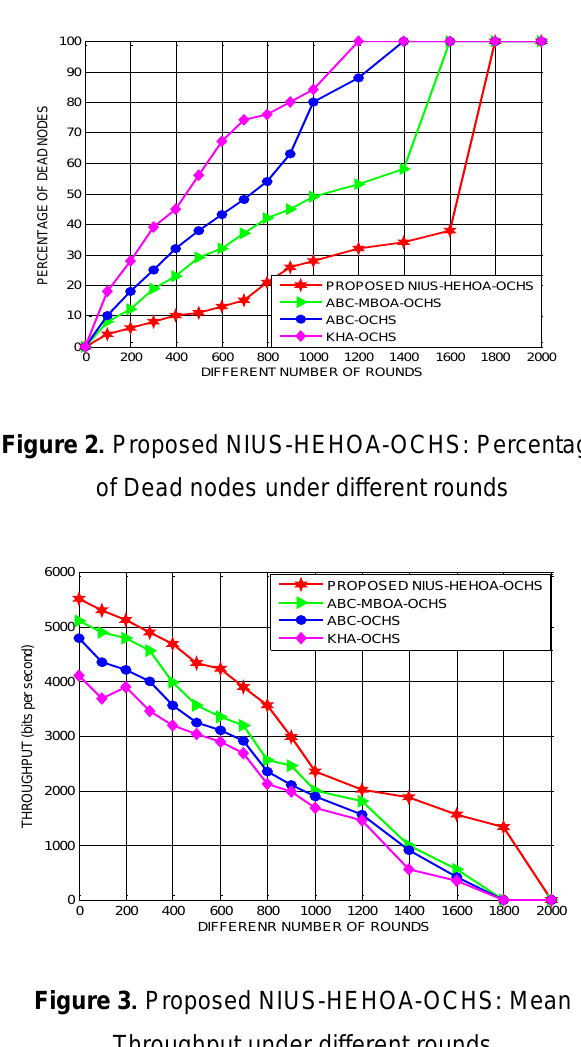
Figure 5 and 6 demonstrates the